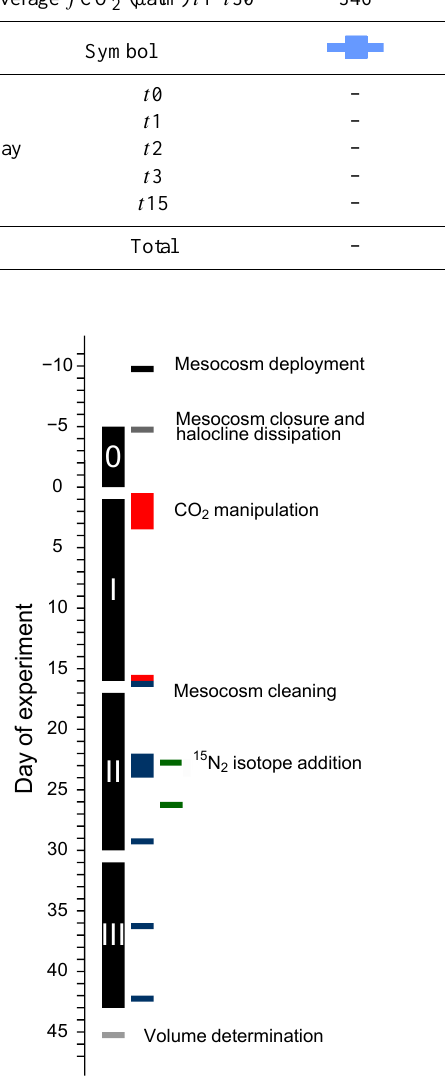
Figure 3. Experiment timeline indicating important activities such